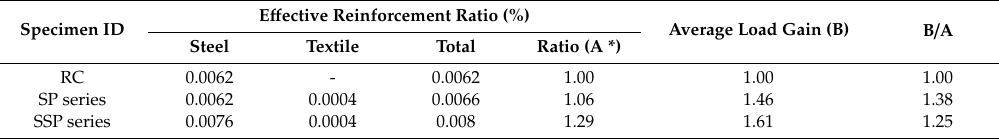
Table 6. Average load gain relative to control